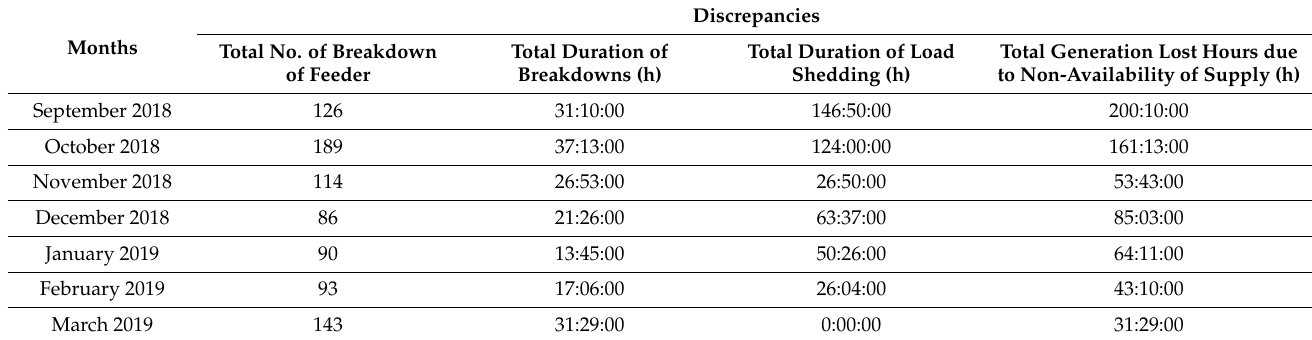
Table 4. Breakdown, load shedding, and a generation lost hours of seven months.